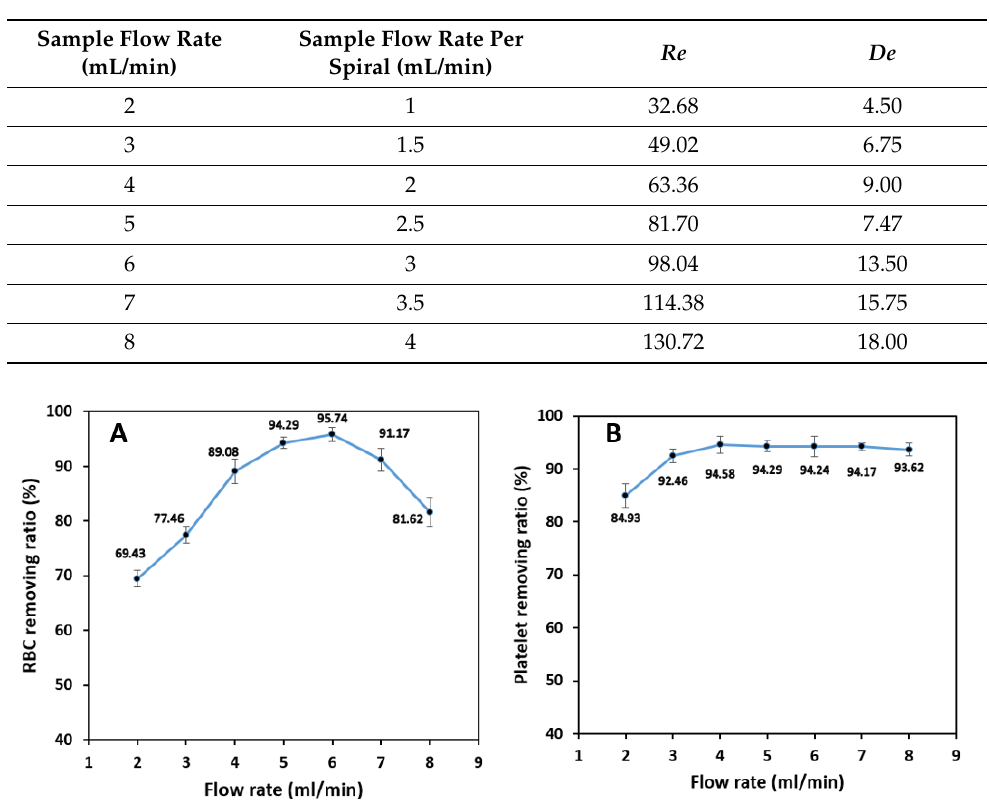
Figure 10. The effect of the sample inlet flow rate on the removing ratio of ( A ) RBCs, ( B ) platelets for 1% blood hematocrit sample. RBC removing ratio is the most sensitive to changes in inlet flow rate with a maximum value at 6 mL/min. The removing ratio of platelets is the least dependent on the flow rate and they can be extracted from the shared outer outlets with high removing ratios.